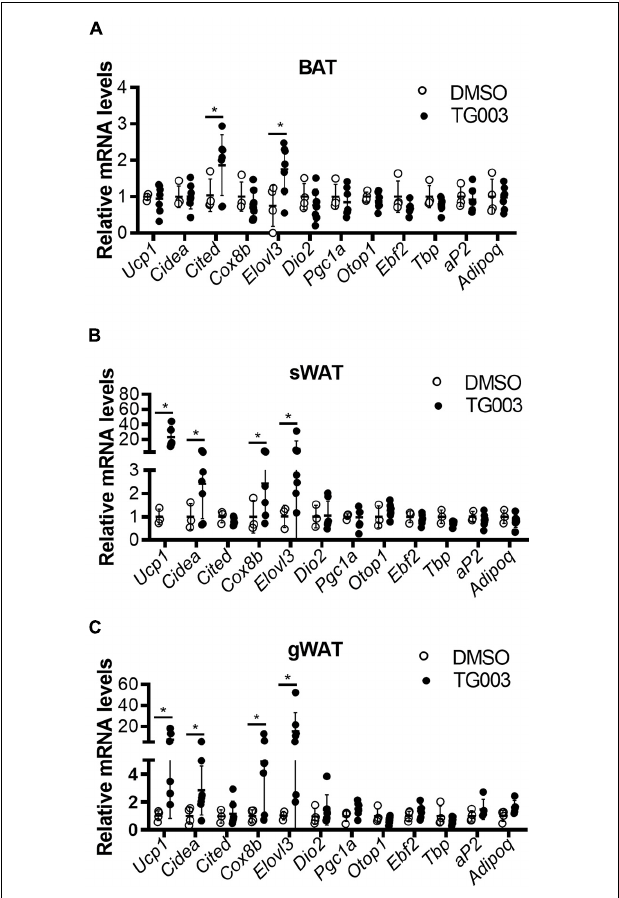
FIGURE 8 | TG003 treatment increases expression of markers of browning in adipose tissues. (A–C) mRNA levels of browning marker genes in BAT (A) , sWAT (B) , and gWAT (C) at the end point of HFD feeding combined with TG003 or DMSO treatment, as described in Figure 7E . n = 6 mice/group. Data shown as mean ± SD. * p < 0.05 vs DMSO. (Unpaired Student’s t test for each